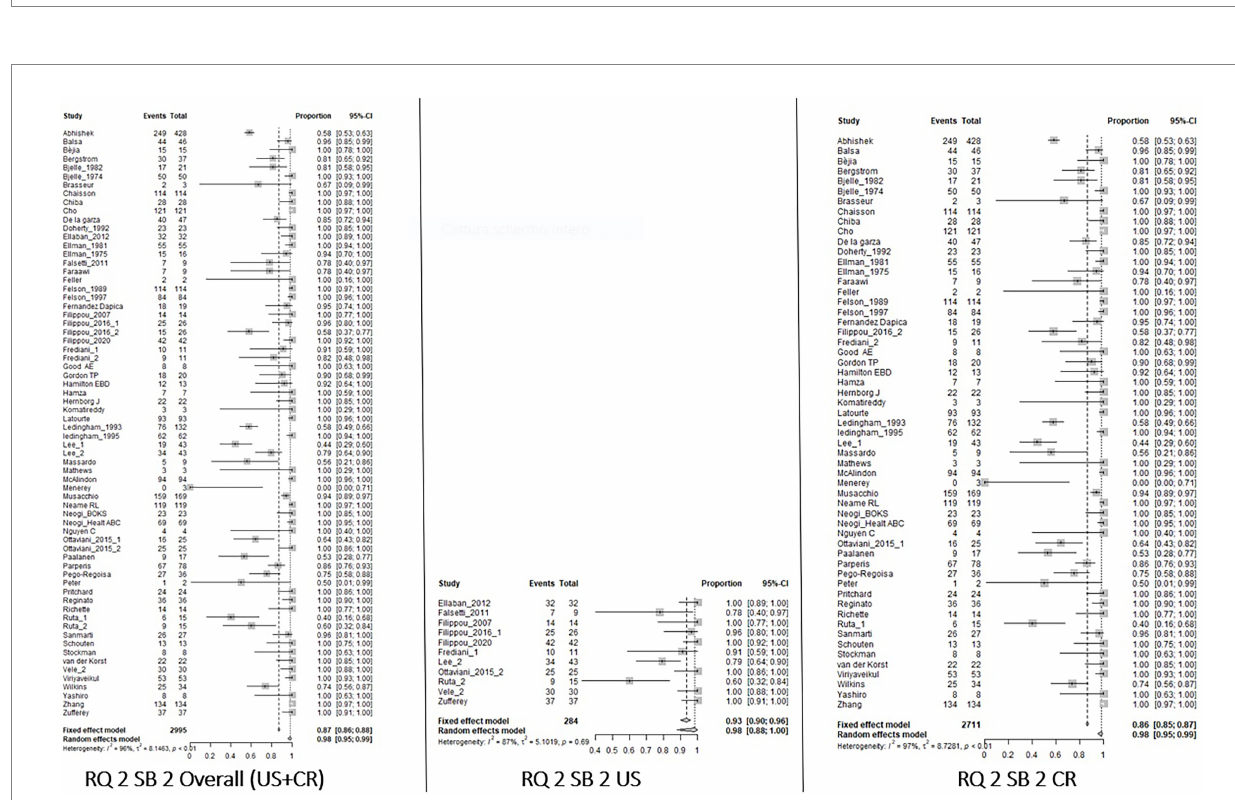
FIGURE 4 Forest Plot Knee, Research Question 2 (RQ 2), Sub_analysis 2: patients with suspected CPPD and knee/wrist used as index joint, independently of the reference standard used for diagnosis, analyzed by imaging.